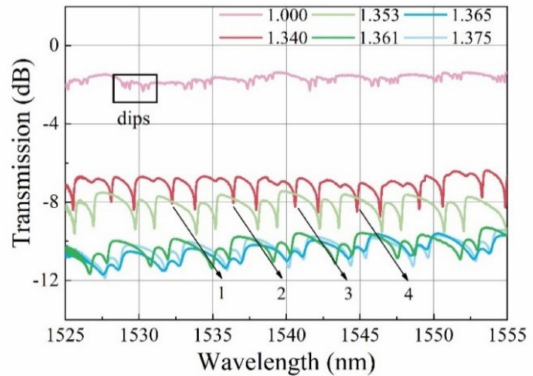
Figure 3. Transmission spectra of the sensing structure when the coupling region is immersed in glycerin solution of different refractive